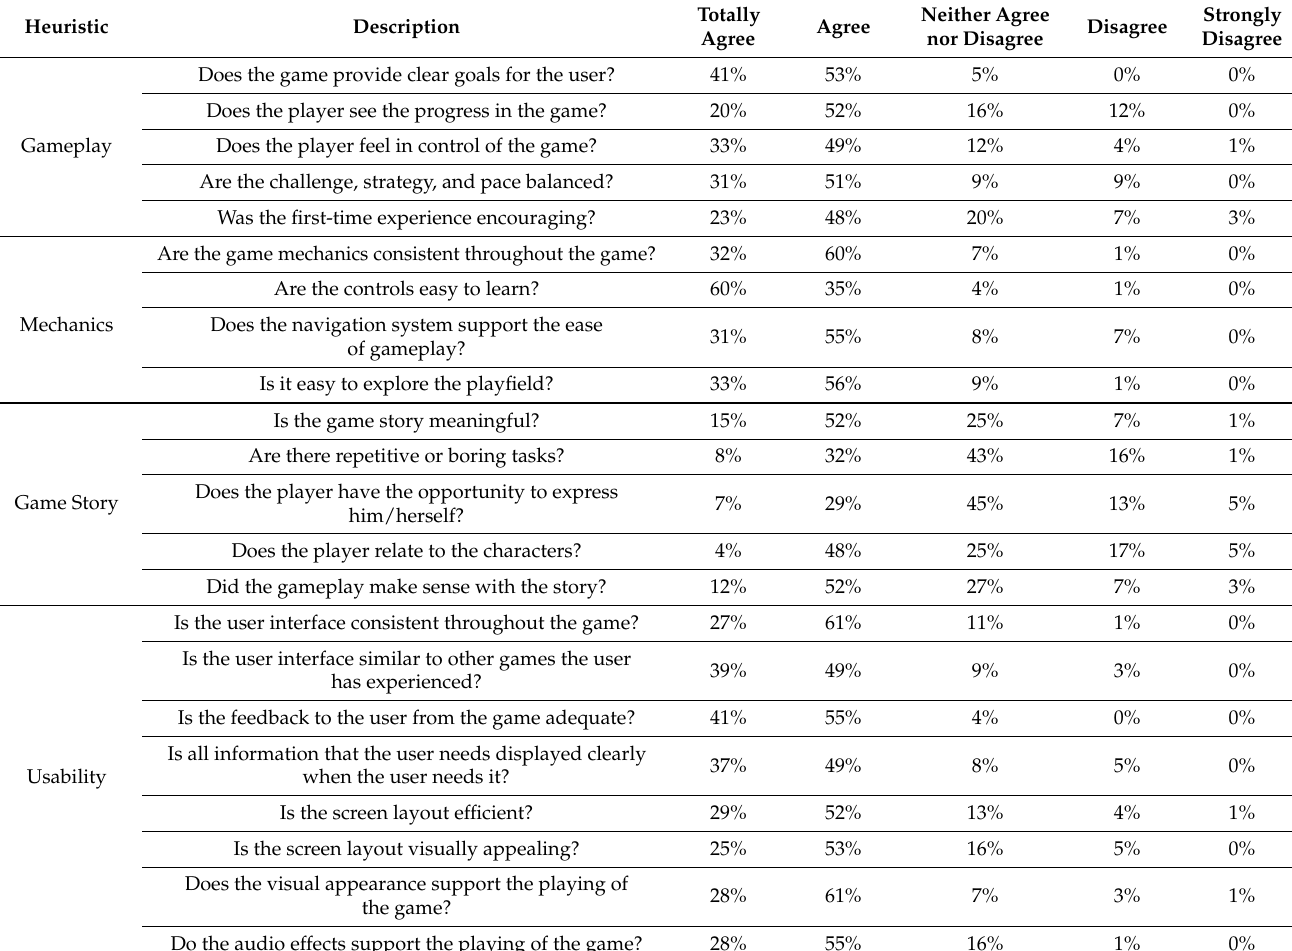
Table 1. Table of questions for the